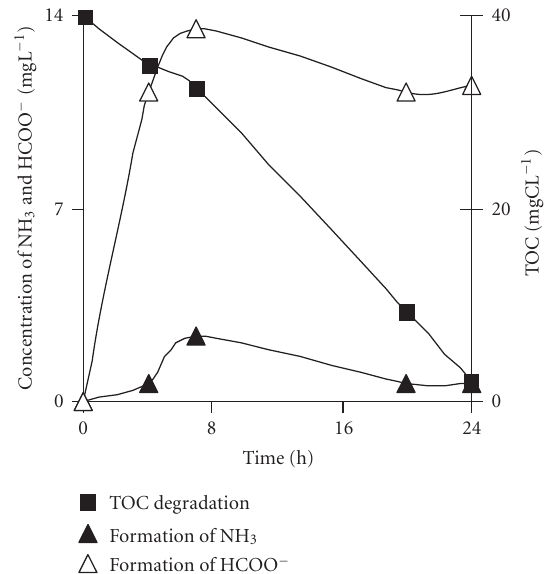
Figure 3: TOC degradation ( (cid:2) ), formation of NH 3 ( (cid:3) ) and HCOO − ( Δ ) in PCO of MA at pH 11, and initial concentration of MA 100mg L − 1 .